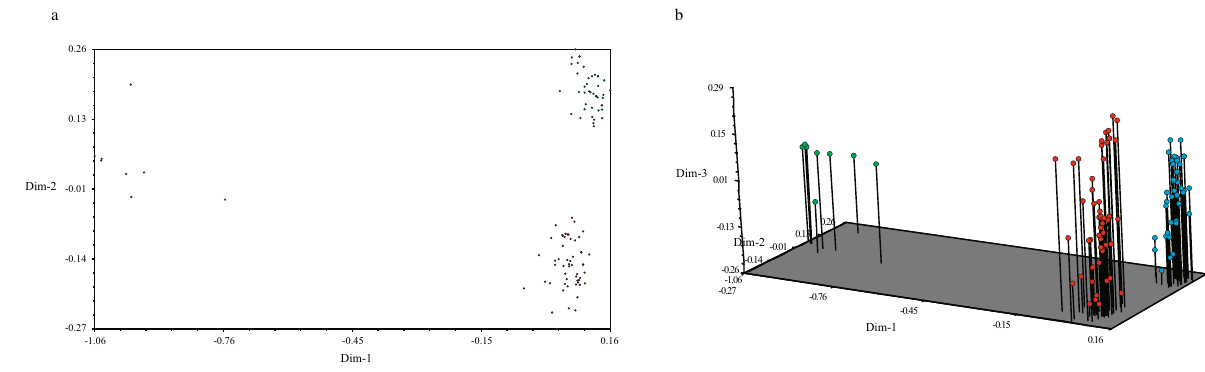
Figure 3. Two-dimensional ( a ) and three-dimensional PCAs ( b ) among the 105 sweet potato accessions based on 6 RBIP primer pairs (I represented by green, II by red, and III by